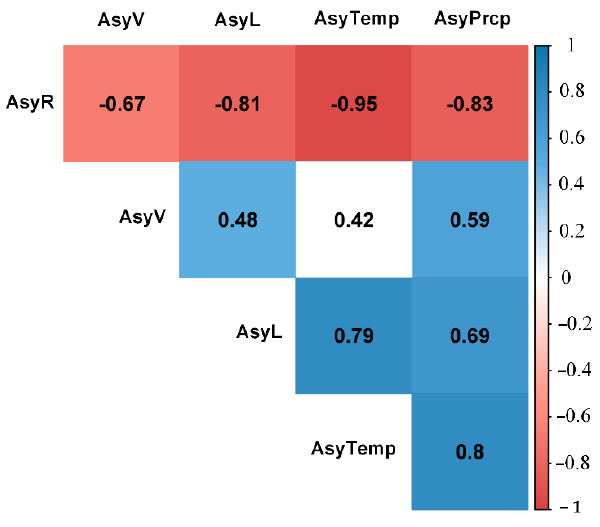
Figure 9. Correlation matrix among the asymmetry time series for temperature, precipitation and vegetation growth asymmetries over the entire Northeast China (NEC) (blank block denotes insignificant